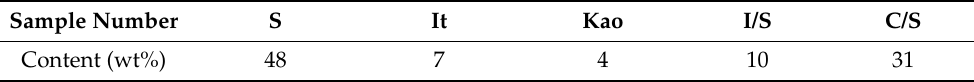
Table 2. Clay composition analysis of clay minerals in insoluble sediments from well A.